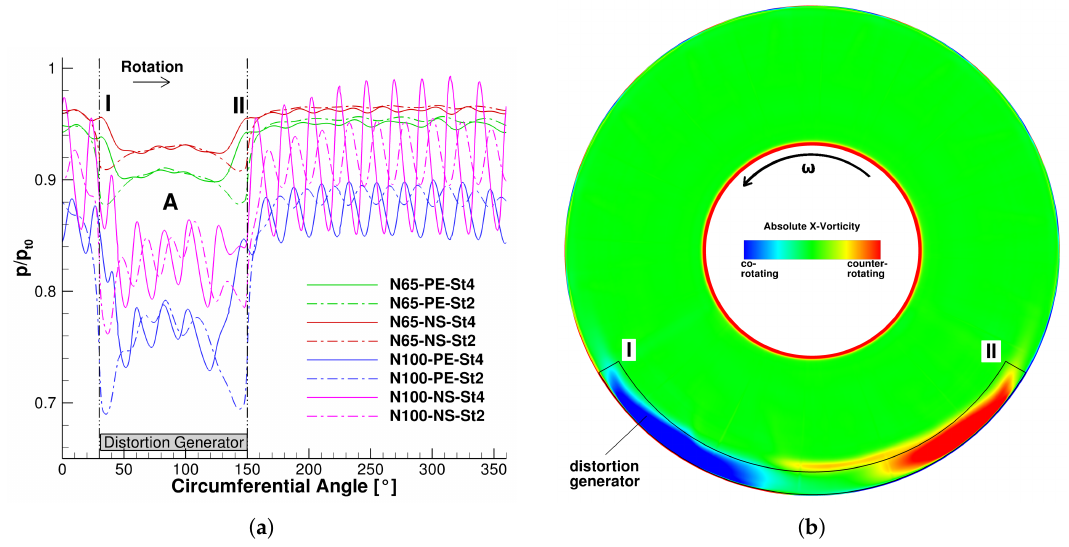
Figure 3. ( a ) Normalized static pressure variation around the annulus at station 2 and 4 (see Figure 2); ( b ) Absolute X-vorticity at station 4 (see Figure 2), N100